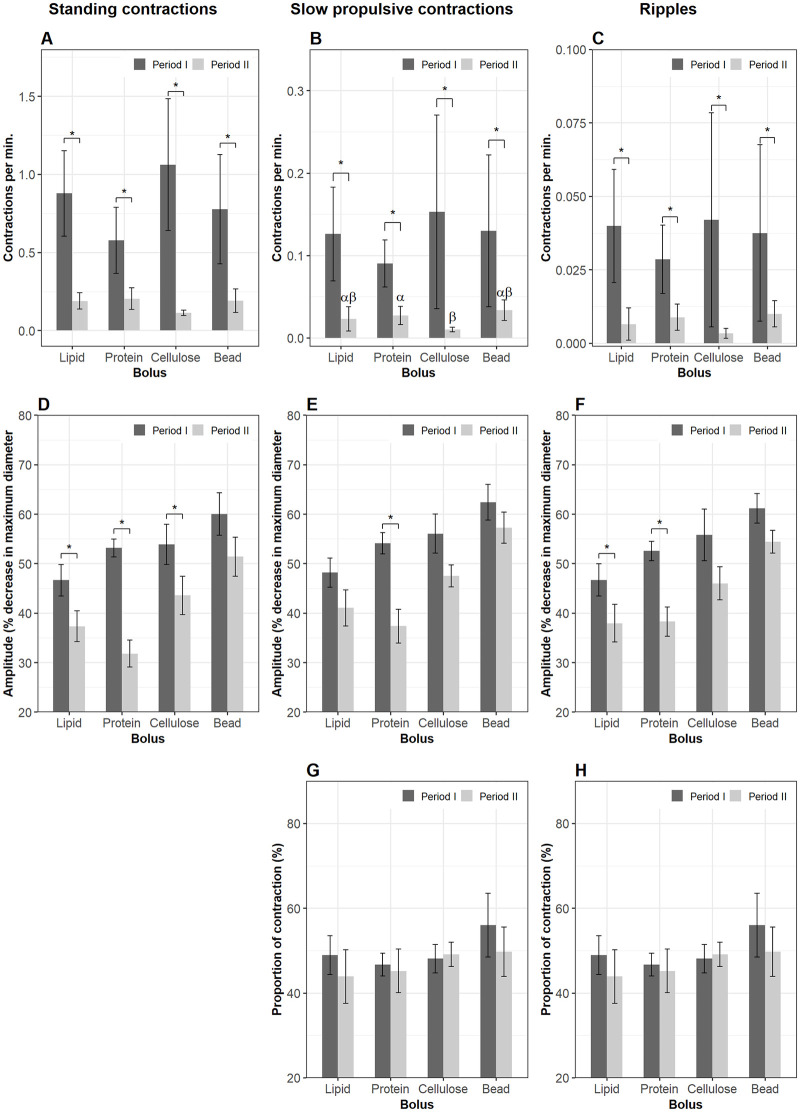
Motility parameters in Segment 4 (the hindgut).Contractions were analyzed in Segment 4 of the intestines when a nutrient bolus (lipid, protein, cellulose or plastic bead) was presented (period I) and after the bolus leaves (period II) Segment 1. Frequency (mean±s.d.) of standing contractions (A), slow propulsive contractions (B) and ripples (C). Amplitude (median±s.e.m.) of standing contractions (D), slow propulsive contractions (E) and ripples (F). Significant differences (p < 0.05) between the four bolus treatments within period I are annotated by Latin letters and differences within period II by Greek letters. Asterisks and brackets show a significant difference (p < 0.05) between periods. Data were analyzed using linear mixed-effects models—lme test followed by Tukey HSD in R for (A–C); Generalized Linear Mixed Models via PQL—glmmPQL test for (D–F), with n = 11 for lipid, n = 12 for protein, n = 6 for cellulose or plastic bead.